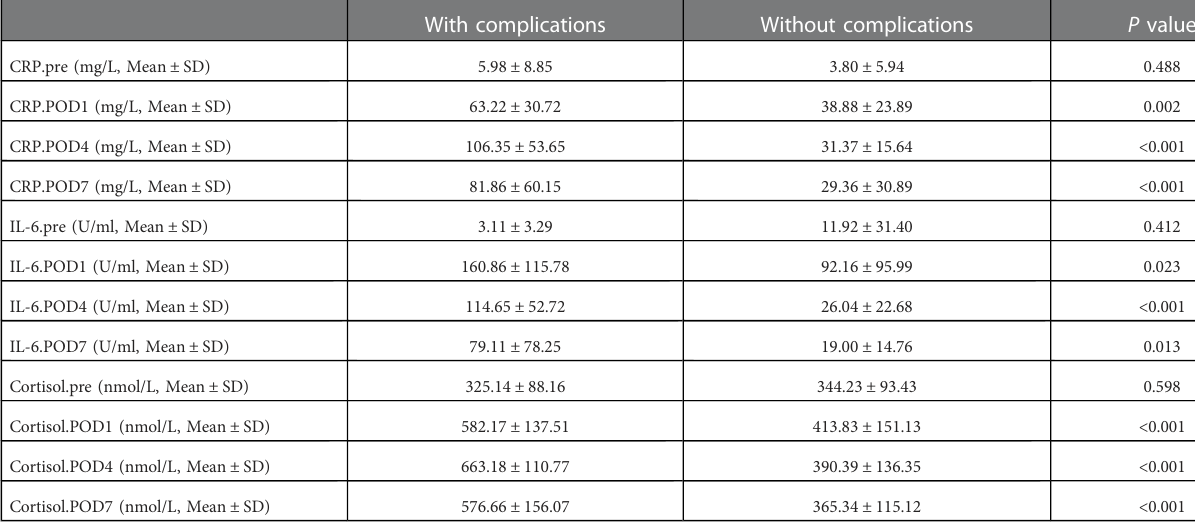
TABLE 4 Perioperative stress index in patients with or without complications.